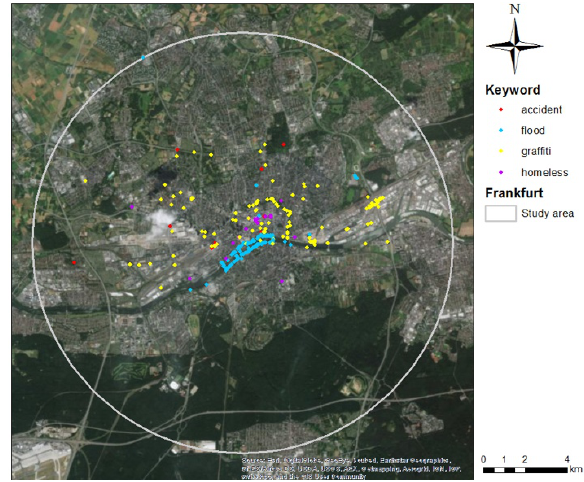
Figure 4. Position of the extracted posts for the Frankfurt study area, coloured according to the keyword used in the search, and